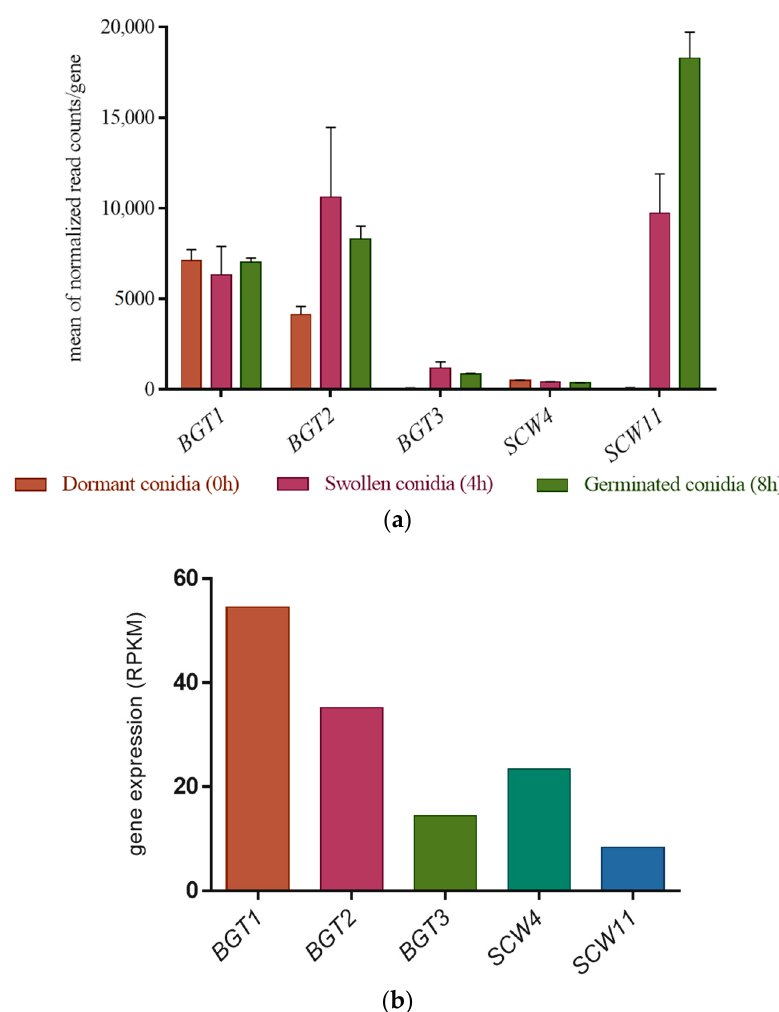
Figure 1. ( a ) Gene expression profile of the GH17 family genes in dormant (T 0 h), swollen (T 4 h), and germinated conidia (T 8 h) in Glucose 3%/YE 1% media, in the parental strain. The data are extracted from RNAseq analysis data [35]. The errors bars represent standard deviation from the mean values of three different experiments; ( b ) Gene expression level of the GH17 genes in the mycelium during conidiation of the parental strain (WT), values are taken from the RNA-seq data analysis of Valsecchi et al., 2017 [36]. For this RNA-sequencing experiment, the fungus was grown for seven days on malt agar at 37 °C at room temperature.